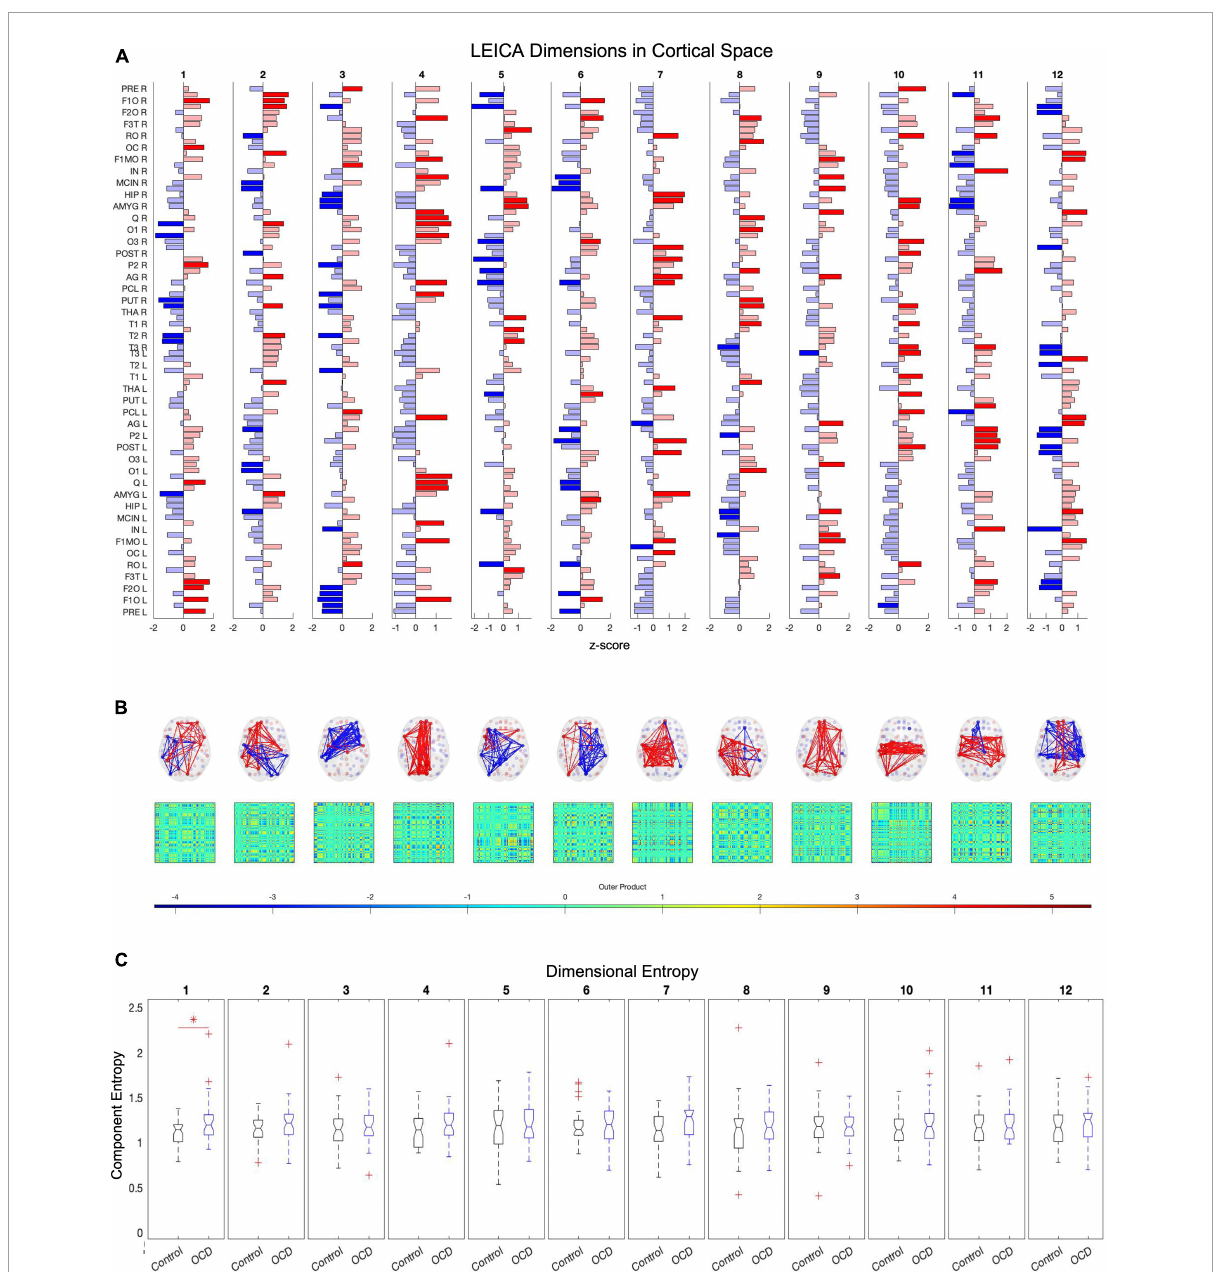
FIGURE4 Twelve of the eigenvalues of E’s autocorrelation matrix exceed the upper limit of the Marˇcenko-Pastur distribution, suggesting that 12 dimensions are necessary to capture E’s activity. Independent component analysis reveals how these dimensions map to brain regions (A) . Map weights have been converted into z-scores for this figure and regions with a weight z < 1.3 are depicted in faded color. Plotting these mapping vectors in the brain and as connectivity (B) reveals that the trailing dimensions (9, 10, 11, and 12) display notable homotopic symmetry, while leading dimensions are strongly asymmetric. Finally, group-level entropy analysis shows that the first dimension displays significantly higher entropy in obsessive-compulsive patients than in controls (C) . Note that dimensions are ordered according to average activity level across the